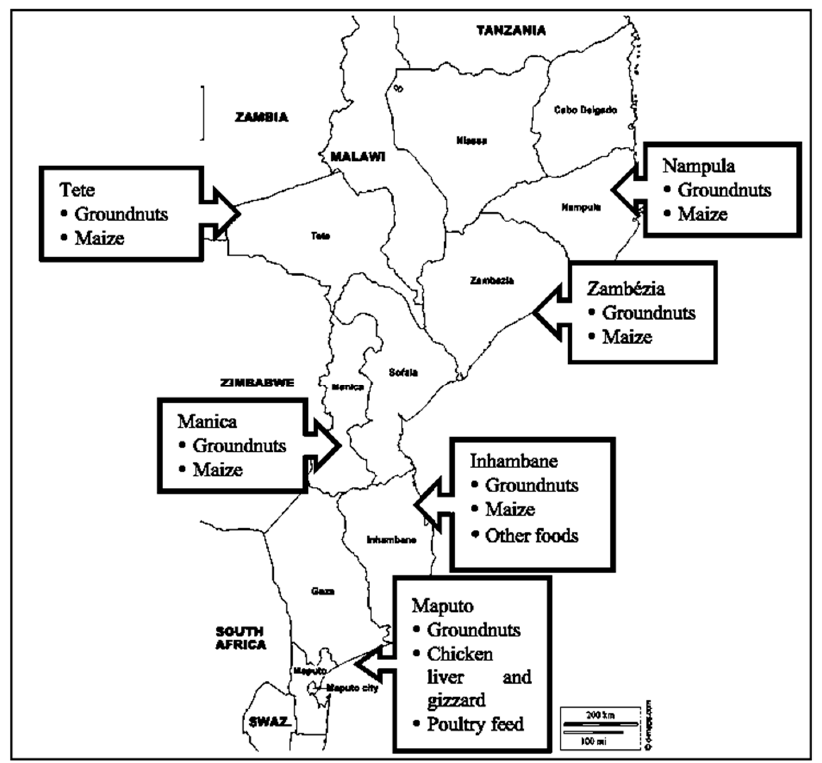
Figure 4. Mozambican provinces where aflatoxins have been detected and the products analyzed. Adapted from D-Maps [31] with data from Casadei [6], Van Rensburg et al. [7], van Wyk et al. [1], Warth et al. [2] and Sineque et al. [8]. These studies were carried from 1985 to 2017 and included in total 934 samples including agricultural crops, chicken livers and gizzards. Casadei [6] found aflatoxins in samples from different areas of Mozambique, though he did not say which regions in his publication. Van Rensburg et al. [7] detected the toxins in samples from